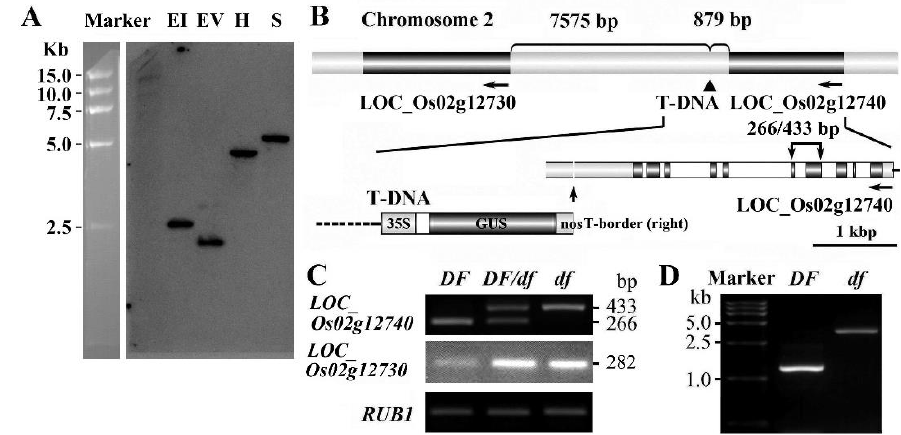
Figure 4. Cloning of the df gene. ( A ) Southern blot for the df mutant using a Hygromycin probe. DNA was digested with Eco R I (EI), Eco R V (EV), Hind III (H), and Sac I (S). DNA size